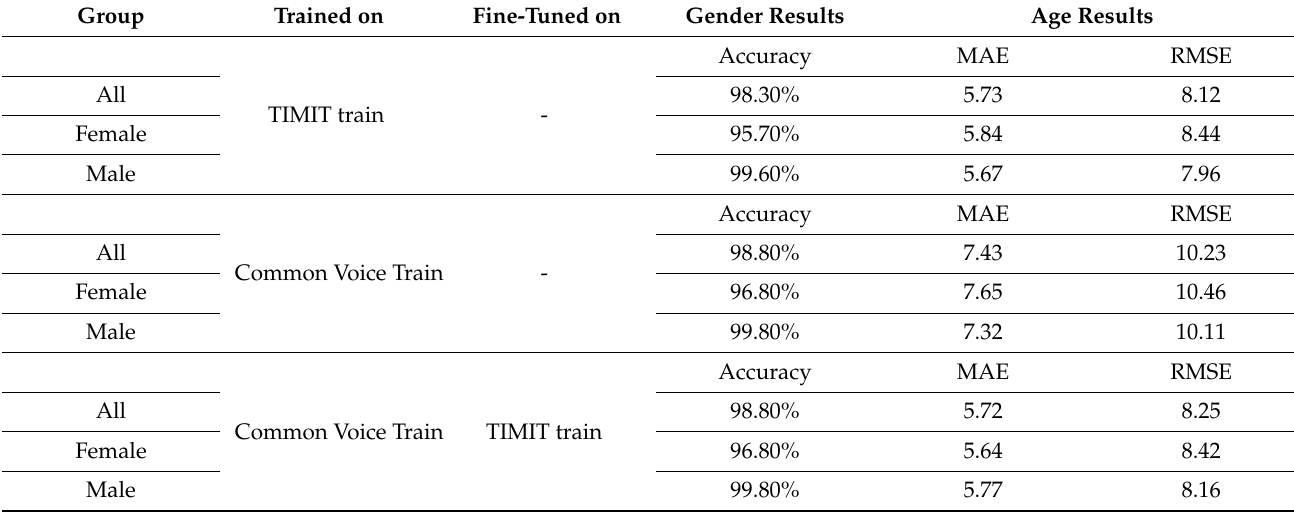
Table 7. Results on the TIMIT test dataset with a baseline x-vector